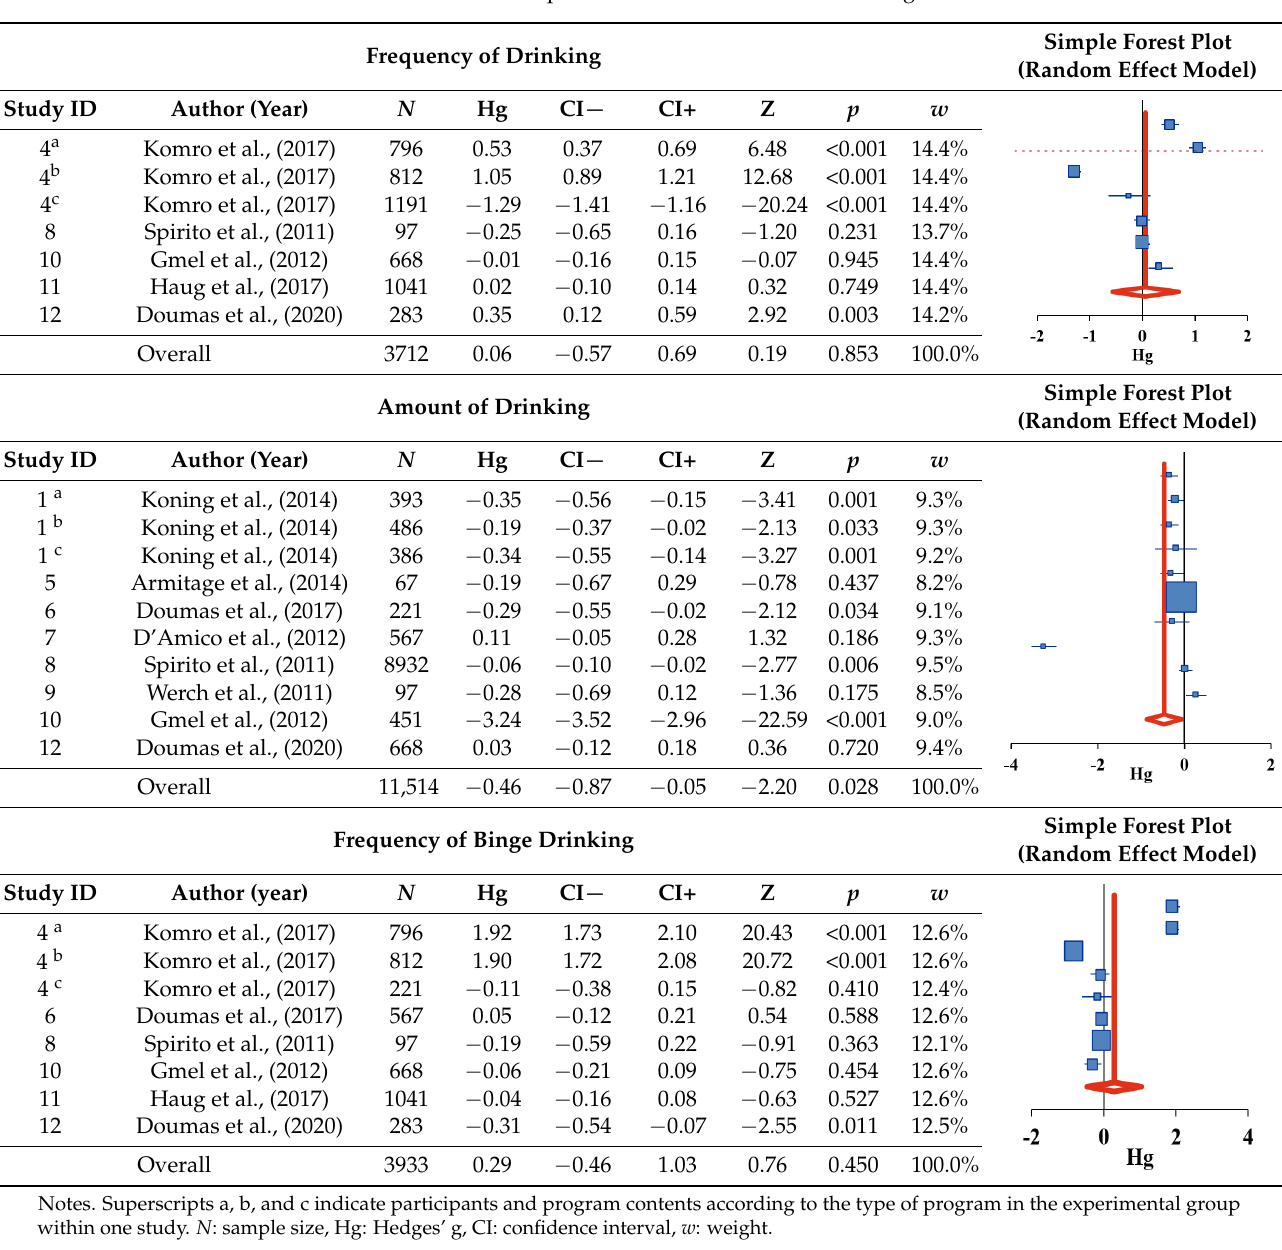
Table 4. The effect size of alcohol prevention interventions on drinking behaviors by intervention characteristics. Variables Characteristics